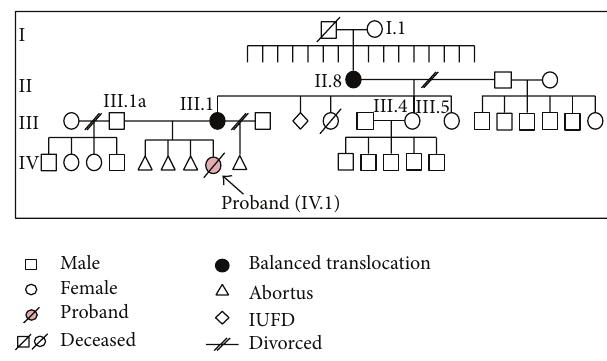
Figure 1: Pedigree of the